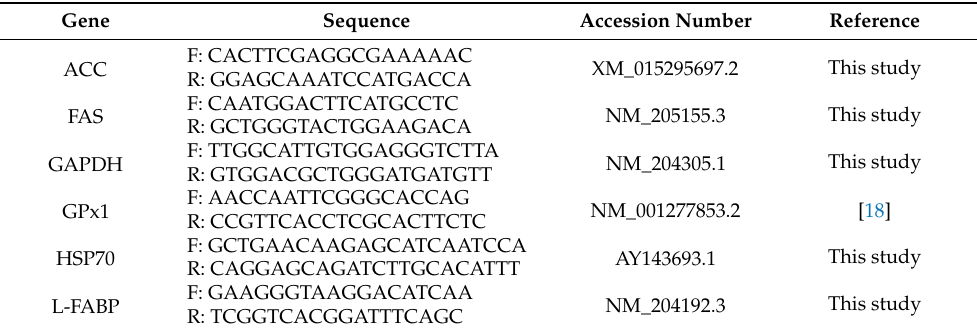
Table 1. Primer sequences used to evaluate gene expression in the liver of 10-day-old